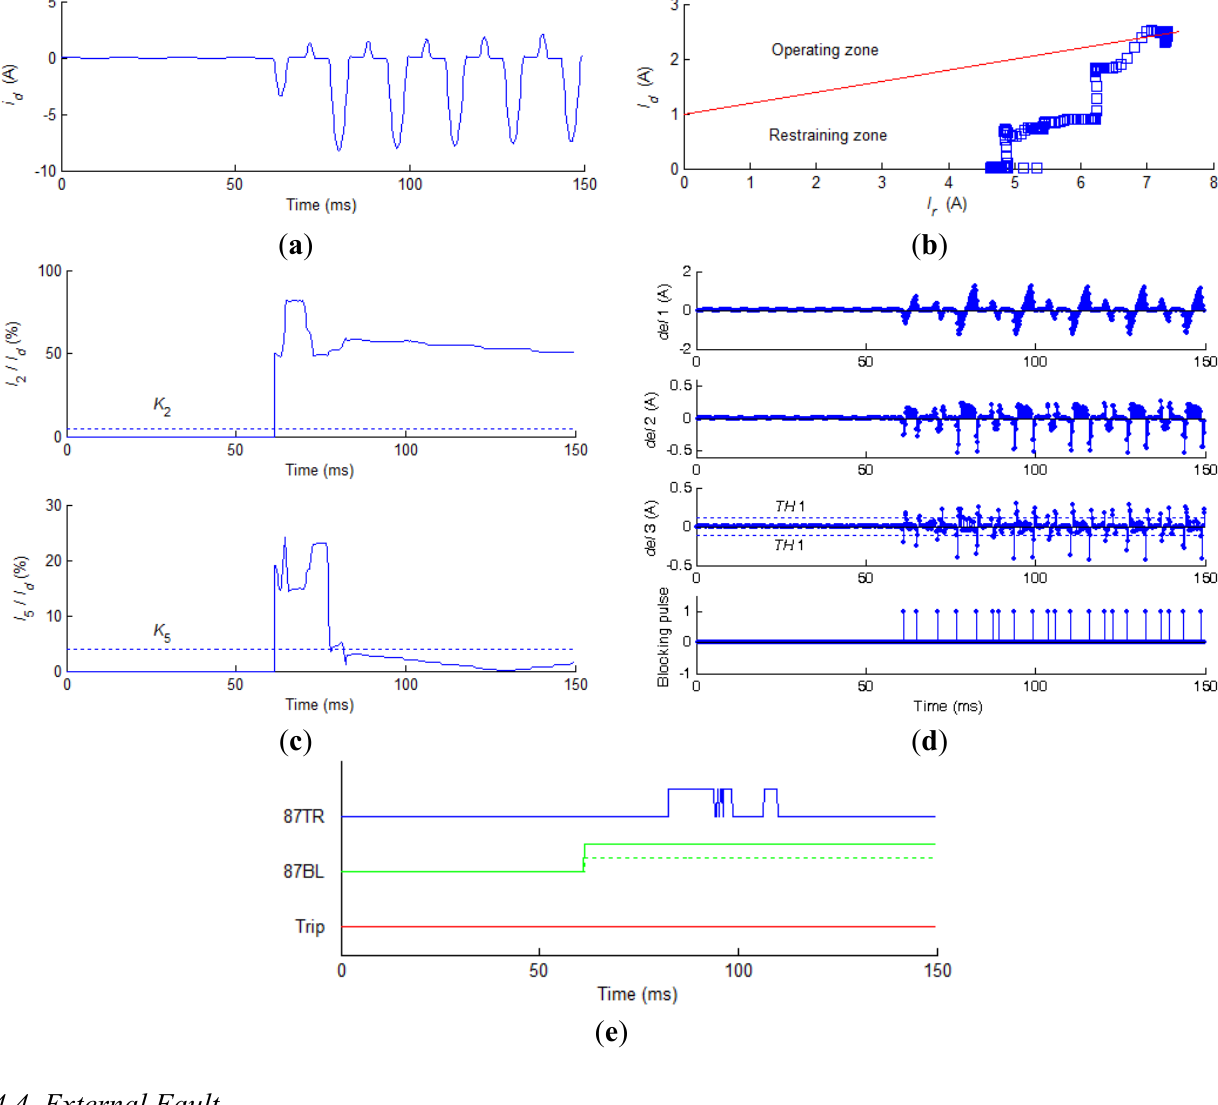
, and blocking pulse; and ( e ) 87TR, 87BL, and trip d